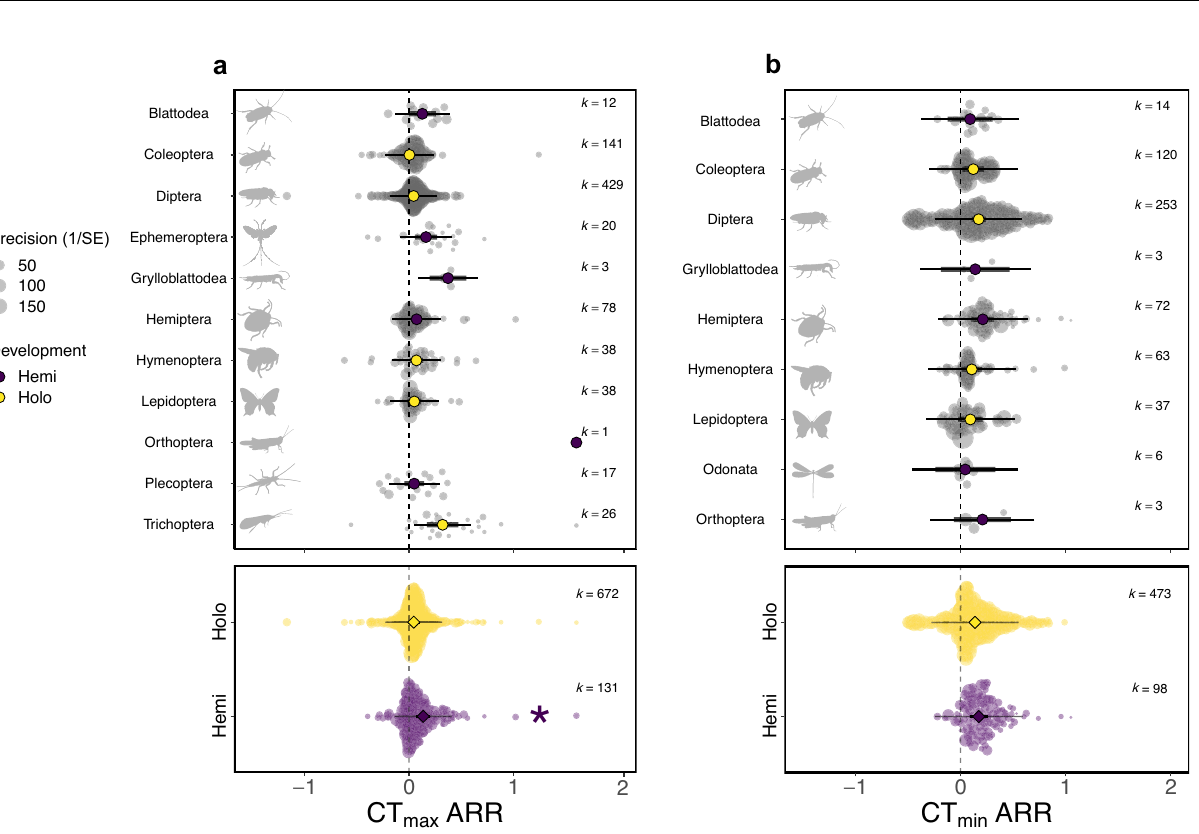
Fig. 3 | The effect ofdevelopment type(holometabolous,metamorphosing insects; orhemimetabolous,non-metamorphosing insects) onacclimation response ratio(ARR) for a CT max (k=803)and b CT min (k=571). MeanARR are arranged by InsectOrder(alphabetical), coloured bydevelopment type. 95%con fi denceintervals (95%CIs)aredepictedinheavyblacklines(sometimeshiddenbythemeandatapoint,depictedbyadiamondorcirclesymbol),predictionintervalsinthinblacklines.The size of each data point is proportional to the precision of the study (1/SE (Standard Error)). k=number of effect sizes per group. Asterisk indicates that 95% CIs do not overlap, comparisons are made between the two development types. Icon credit: phylopics.